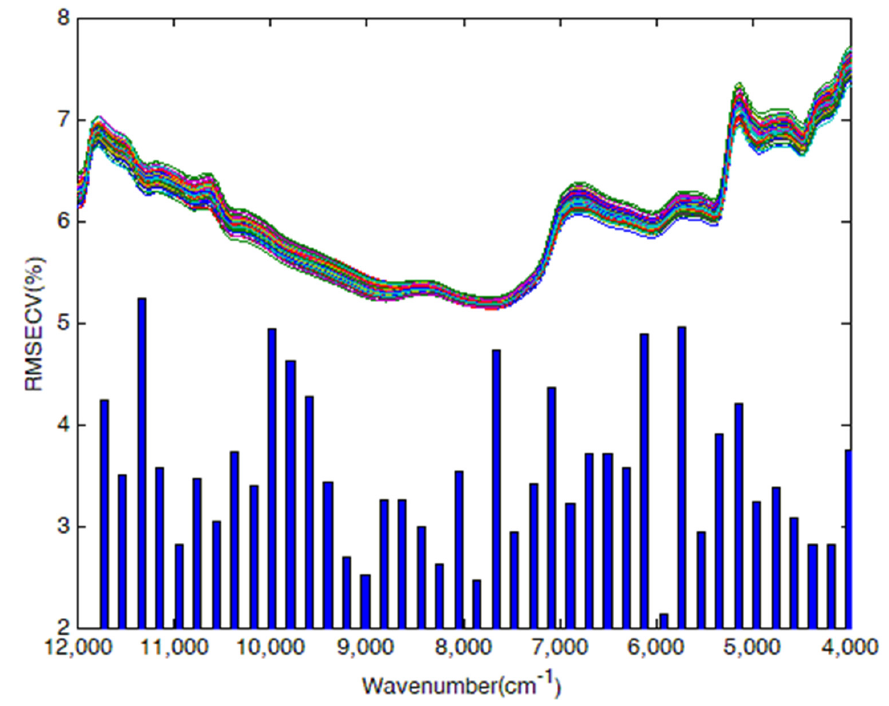
Figure 2. Plots of characteristic variable selection based on iPLS for cellulose in Sargassum